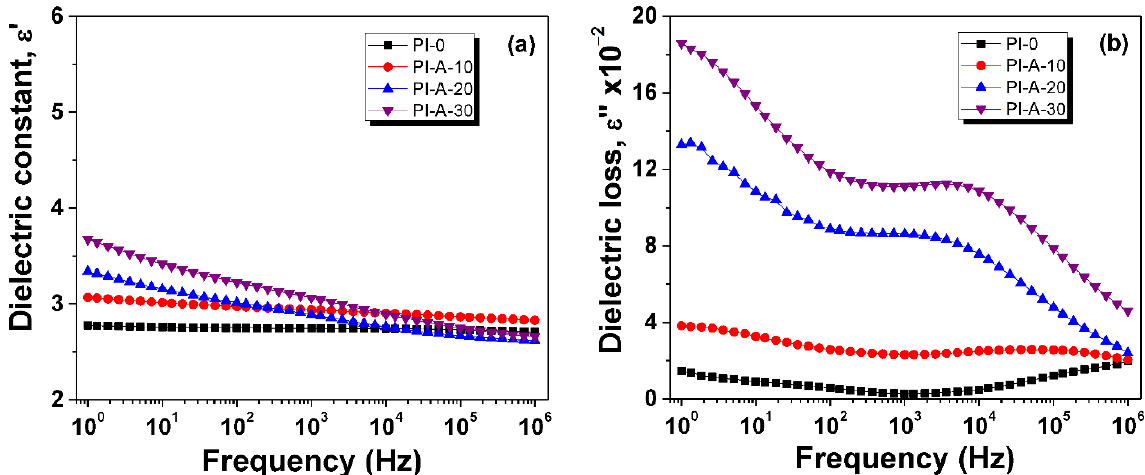
Figure 5. Dielectric constant ( a ) and dielectric loss ( b ) evolution with alternating frequency for PI-0, PI-A-10, PI-A-20, and PI-A-30, at 25 °C.